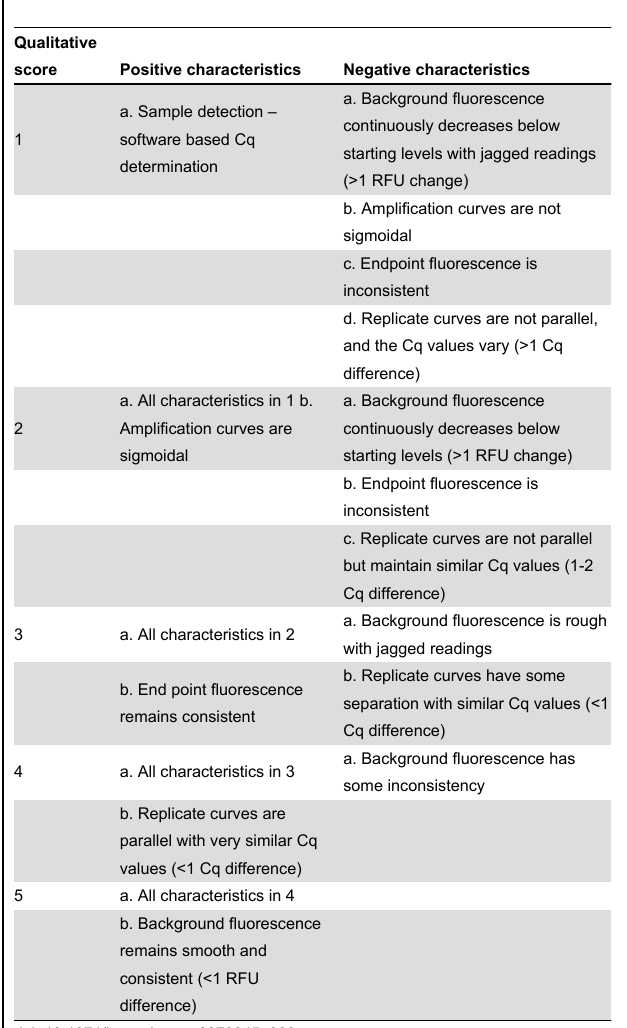
Table 2. Description of the real-time PCR curve scoring. Table 3. Preliminary LOD determination (2/2) using FT-MM across each